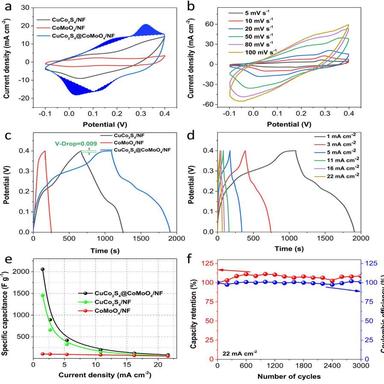
Nyquist plots obtained for the CuCo2S4/NF, CoMoO4/NF, and CuCo2S4@CoMoO4/ NF electrodes.